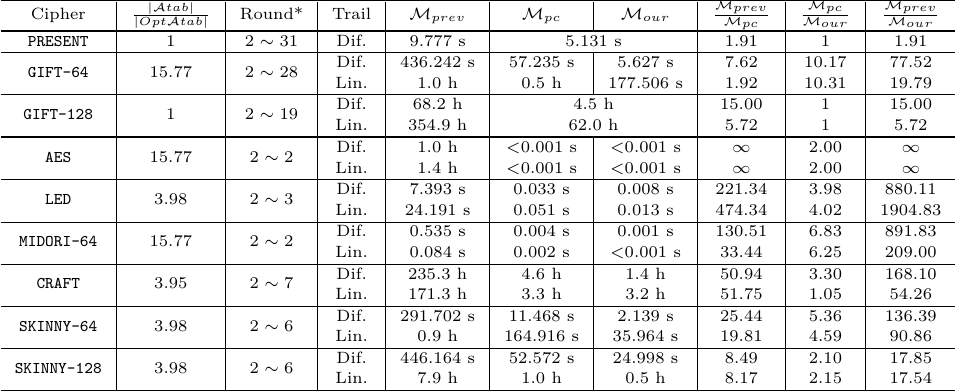
Table 4: Performance Comparisons of Best Trail Searches on the Considered Ciphers